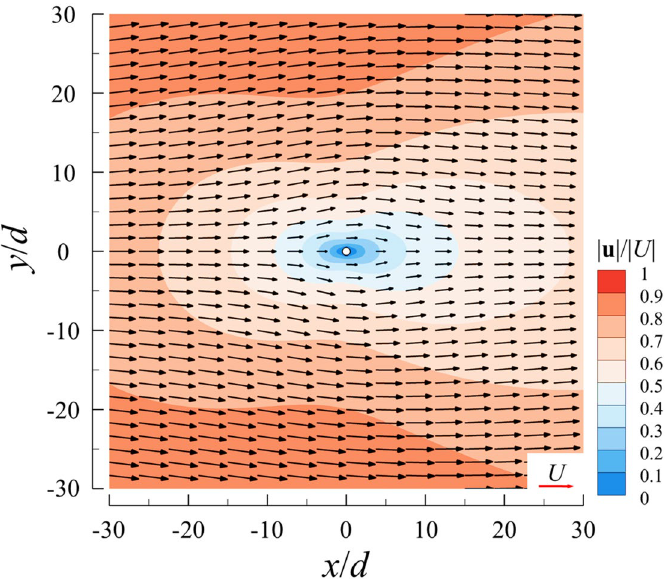
Figure 10. The plot of non-dimensional velocity vector and its magnitude contours around an isolated cylinder.